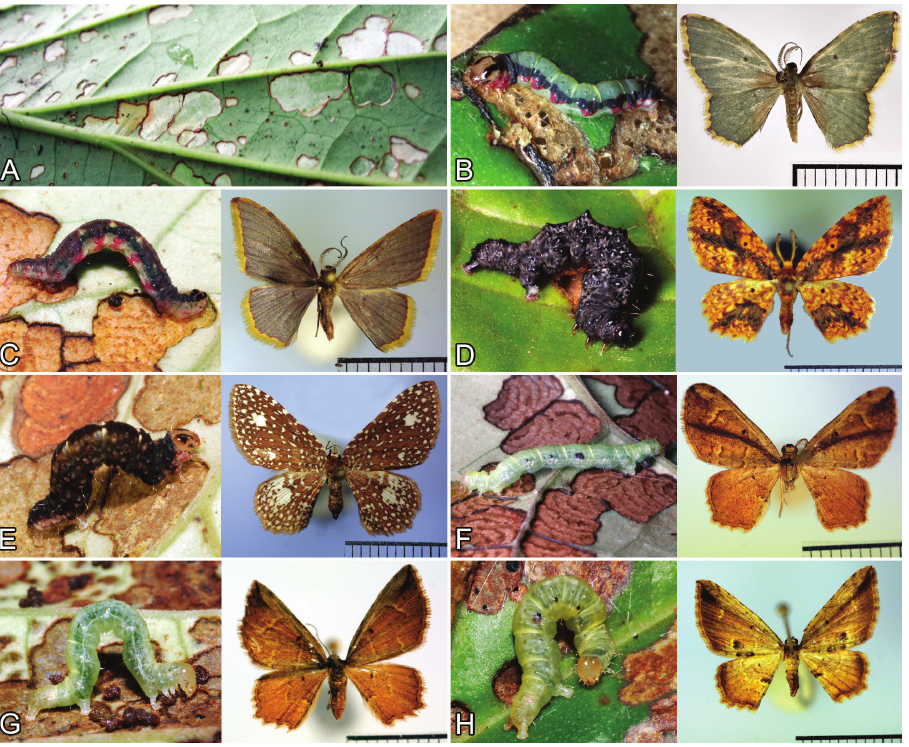
Figure 4. A Leaf of Piper kelleyi with characteristic herbivory marks or “windows” made by the specialist herbivore Eois ; species of Eois that specialize on Piper kelleyi include B Eois viridiflava (Dognin) C E . aff. viridiflava (Dognin) D E. ignefumata (Dognin) E E. planetaria (Dognin) F E. aff. pallidicosta (Warren) G E. encina (Dognin) h E. aff. encina